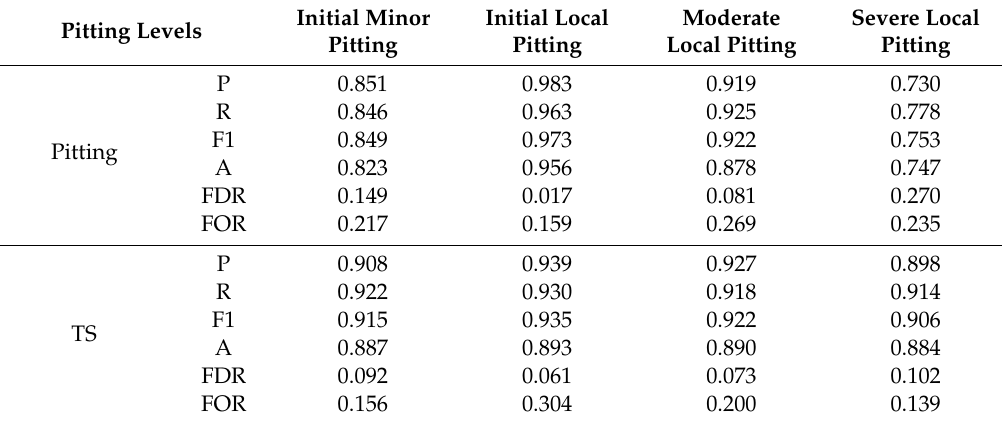
Figure 10. Evaluation parameters of gear pitting and tooth surface (TS) under di ff erent pitting levels. ( a ) Initial pitting (pitting); ( b ) Initial local pitting (pitting); ( c ) Moderate local pitting (pitting); ( d ) Severe local pitting (pitting); ( e ) Initial pitting (TS); ( f ) Initial local pitting (TS); ( g ) Moderate local pitting (TS); ( h ) Severe local pitting (TS). Table 3. Detection results under di ff erent gear pitting